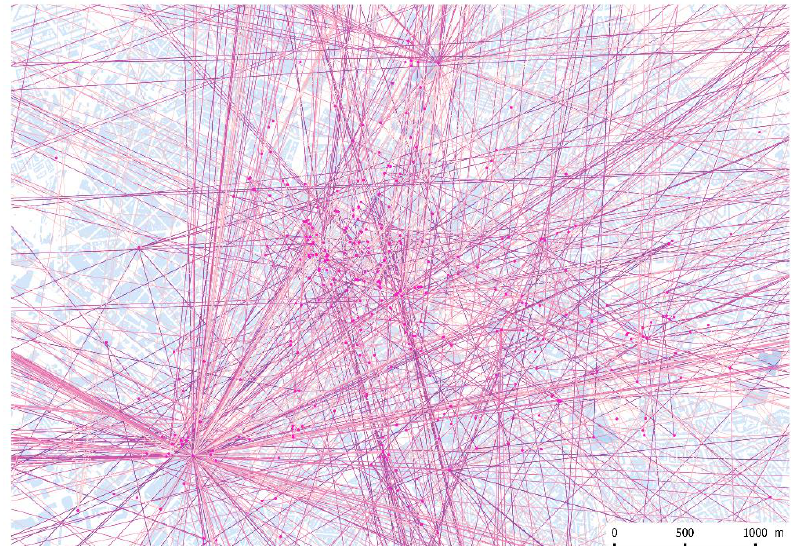
Figure 7. A representation of the trajectories effected by all the individuals who made at least one check-in at the “Midi Station” in Brussels in Belgium. A different color is associated with each username. It is impossible to retrieve information based on such kind of representation. This shows the importance of using a spatio-temporal model as developed here to retrieve information from LBSN datasets.